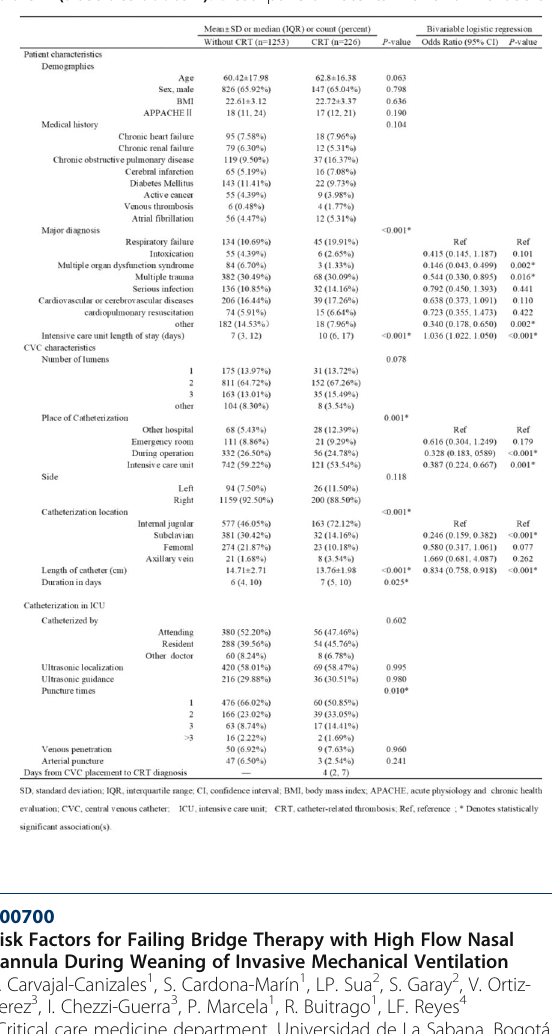
Table 1 (abstract 000694). Descriptive of Patents with and without